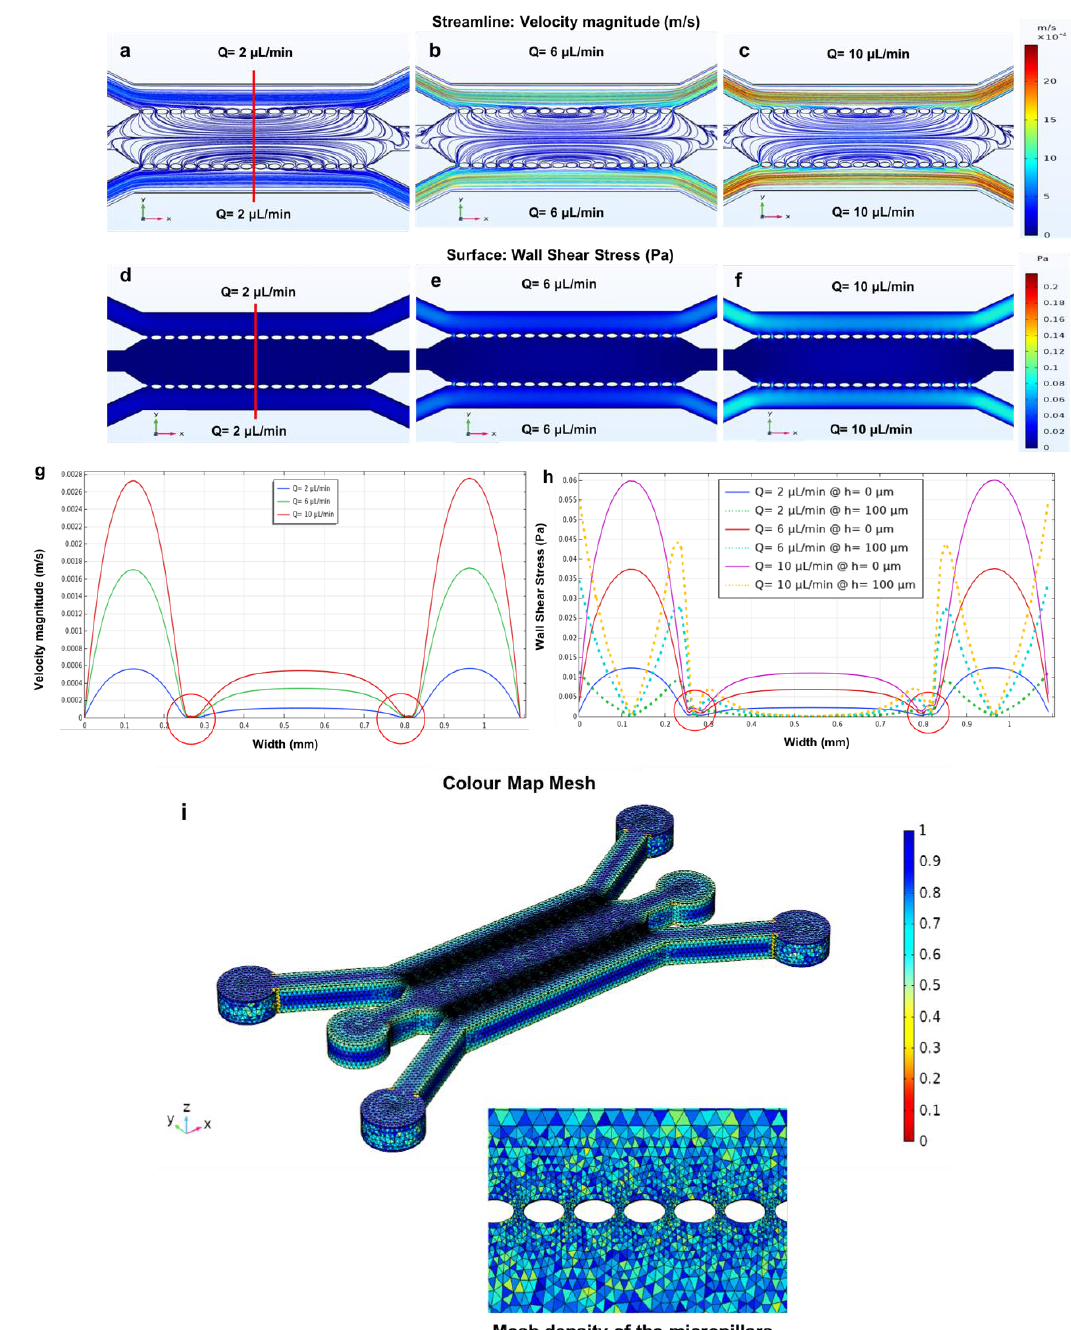
Figure 7. The fluid flow simulation of the three parallel microchannels separated by two rows of micropillars with ( a ) flow rates of 2 µL/min; ( b ) 6 µL/min and ( c ) 10 µL/min, which are plotted versus the width of the device using three different flow rates within the side microchannels. The wall shear stress simulation in the three parallel microchannels device with a height of 200 µm and three different flow rates within the side microchannels at ( d ) 2 µL/min; ( e ) 6 µL/min and ( f ) 10 µL/min (simulated shear stress and velocity magnitude along red line); ( g ) the velocity profile; ( h ) wall shear stress profile at the bottom of the microchannels (h = 0 µm, solid lines) and wall shear stress profile at the middle of the microchannels (h = 100 µm, dotted lines); ( i ) generated mesh density study for three parallel microchannels separated by two rows of micropillars. Red circles highlight the velocity and shear stress fluctuations near the micropillar structures.